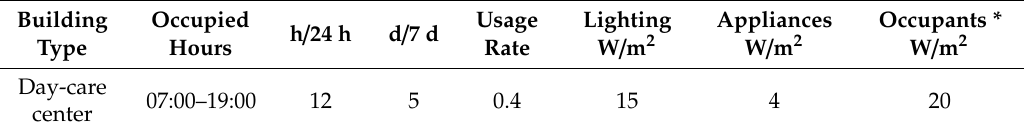
Table 2. Standard use of buildings and the corresponding max. values of heat